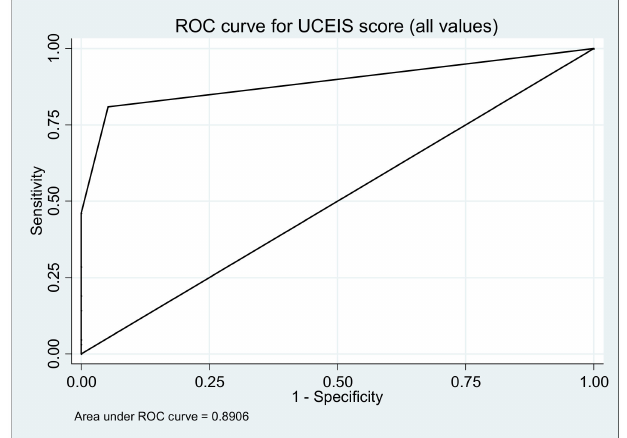
Figure 5. Area under the receiver operating characteristic (ROC) curve to predict ulcerative colitis relapse using the Colitis Endoscopic Index of Severity (UCEIS) score during 12 months. Survival curves (with relapse as event) are depicted in the figures below; all log-rank tests yielded significant results ( p < 0.0001) (Figures